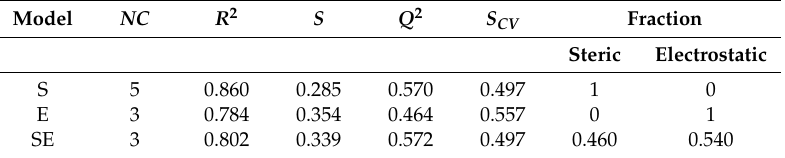
Figure 2. Scatter plot of the experimental activities versus predicted activities for Model SE: ( ● ) training set predictions, ( ○ ) LOO-CV predictions, and (×) test set predictions. Table 2. 3D-QSAR analysis results.